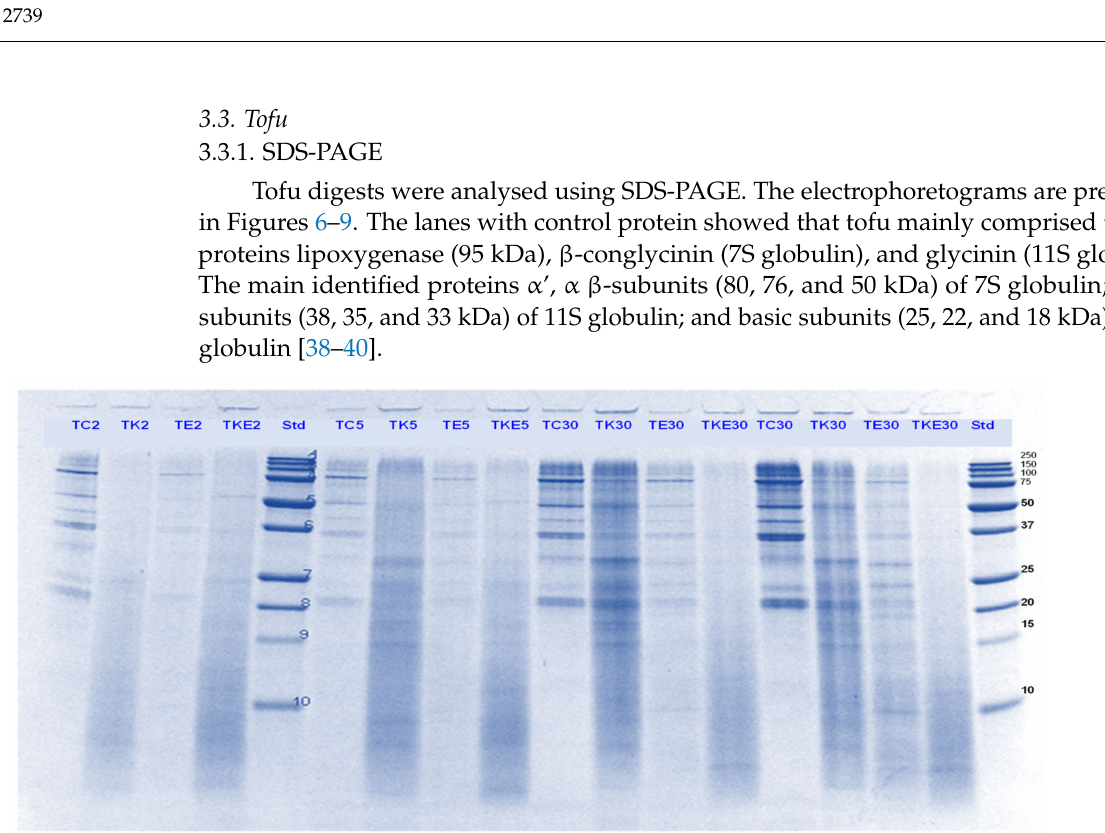
Figure 6. Tricine SDS-PAGE electrophoretogram of tofu (T) digest after 2, 5, 10, and 30 min of simulated oral-gastric digestion in the presence or absence of Hayward (K) kiwifruit extract. TC, Tofu (T) control without any digestive enzymes; TK, with added kiwifruit extract but no digestive enzymes; TE, with digestive enzymes but no added kiwifruit extract; TKE, with both digestive enzymes and green kiwifruit extract. Numbers 2, 5, 10, and 30 are the gastric digestion time following 2 min of oral digestion. Bands (1–10) in the molecular weight standard lane correspond to molecular weights 250, 150, 100, 75, 50, 37, 25, 20, 15 and 10 kDa.